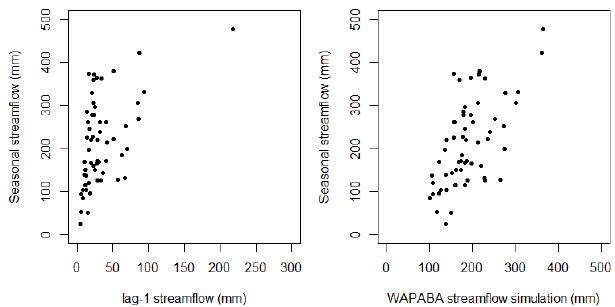
Fig. 10. Relationship between predictors representing initial catch- ment conditions and seasonal streamflow totals for July-August- September inflows into Upper Yarra